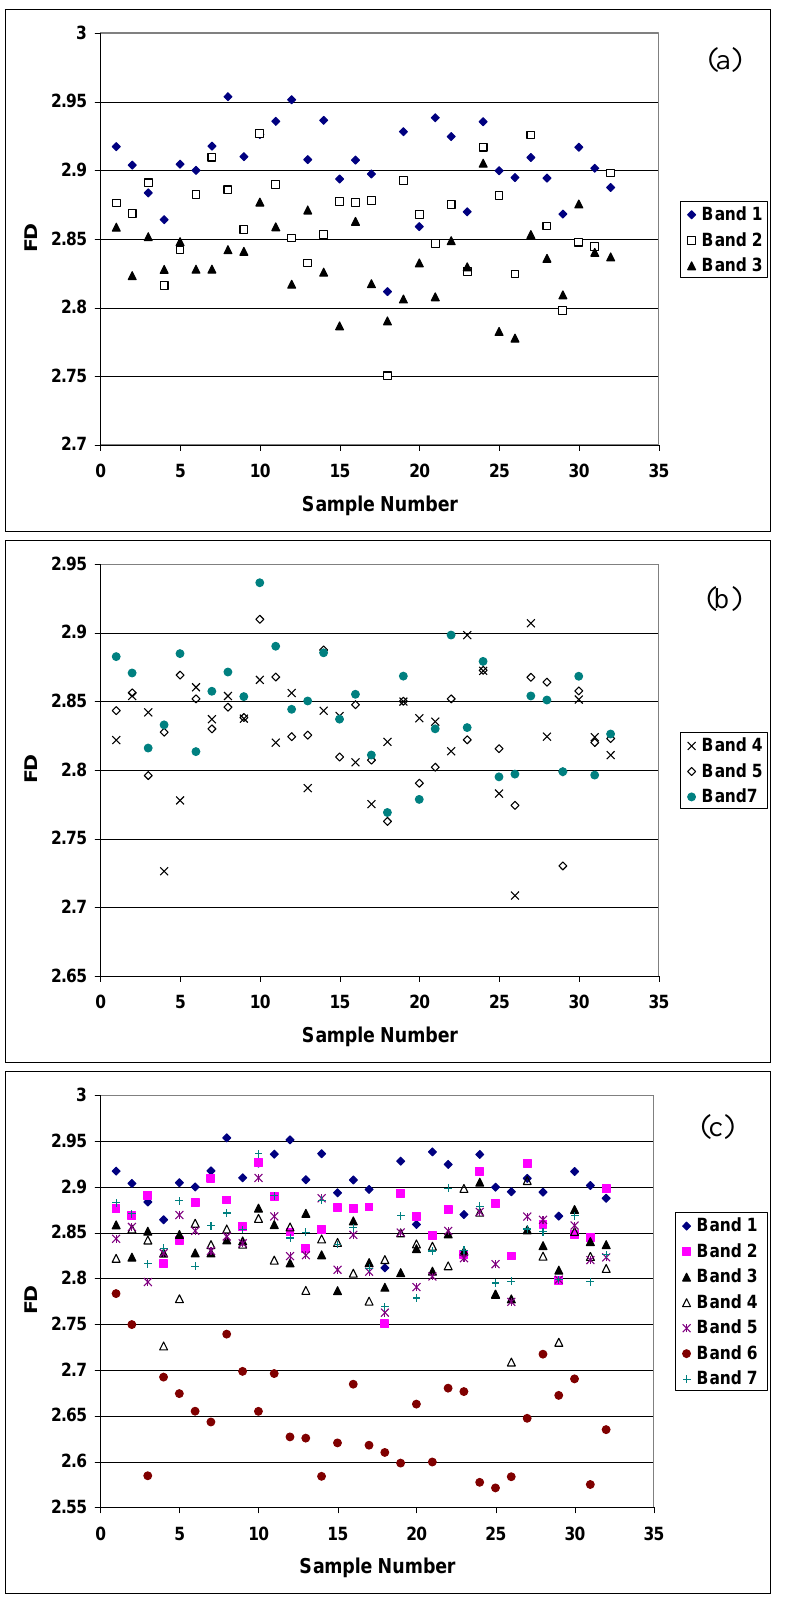
Figure 14. Fractal dimension values of samples within Bankhead National Forest: (a) visible bands (b) near and middle infra red bands (c) all